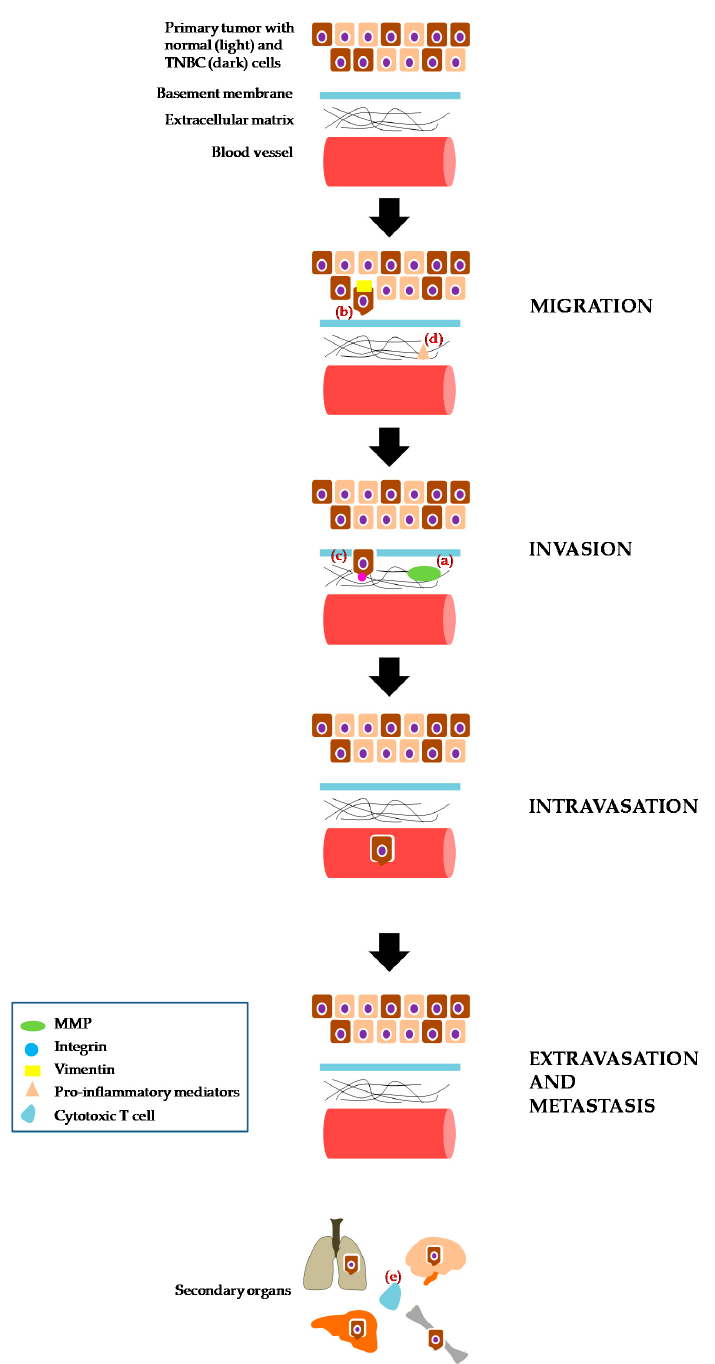
Figure 1. Schematic representation of the metastatic process in triple negative breast cancer (TNBC) and its inhibition by non-platinum metal-based complexes (NPMBC). Metastasis is a sequential and interrelated multi-step process that consists of four main essential steps: migration to adjacent tissue after detachment from a primary tumor; local invasion of cancer cells into adjacent tissue; trans-endothelial migration of cancer cells into vessels (intravasation); transport of cancer cells through the circulatory system with extravasation of them in a secondary organ (brain, lung, liver, bone). The anti-metastatic effect of NPMBC has been associated with their ability: to inhibit matrix metalloproteinases ( a ); to inhibit mesenchymal markers such as vimentin ( b ); to interfere with the function of integrins ( c ); and to modify the immune/inflammatory response ( d , e